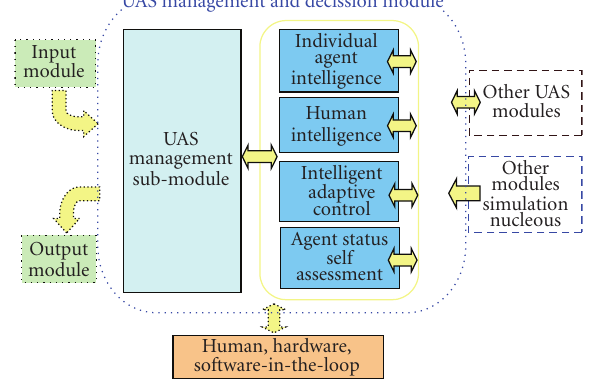
Figure 8: UAS-SE—UAS management and decision module.